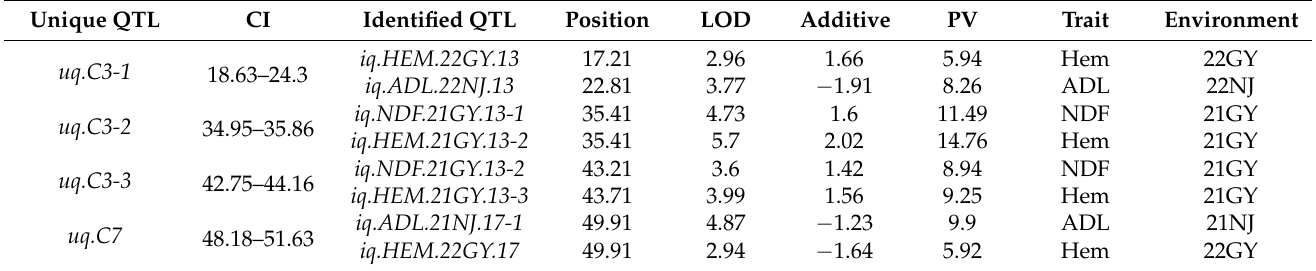
Table 3. Unique QTLs for crude fiber component detected in four